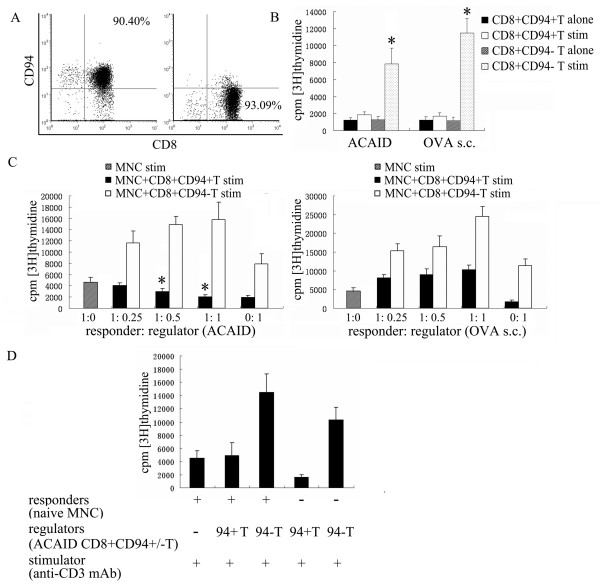
Suppressive activity exhibited by CD8+CD94+T cells from ACAID mice in vitro. A: the purity of isolated CD8+CD94+T (left) and CD8+CD94-T (right) cells by magnetic affinity cell sorting; B: the response of CD8+CD94+T and CD8+CD94-T cells to anti-CD3 mAb stimulation (stim). *p < 0.05 compared with unstimulated group. C: suppressive effect of CD8+CD94+T and CD8+CD94-T cells on the proliferation of splenic MNC. Splenic MNC (5 × 104 cells/well, as responder cells) from immunized mice were cocultured with purified CD8+CD94+T or CD8+CD94-T cells (as regulatory cells) from ACAID mice and immunized mice at different responder/suppressor ratios (1:0, 1:0.25, 1:0.5 and 1:1) in the presence of OVA(100 μg/ml) and anti-CD3 mAb(1 μg/ml) for 72 hours and pulsed with [3H]thymidine for the last 16 hours of culture. Data are represented as mean ± SEM of triplicate samples. *p < 0.05 compared with stimulated MNC group. D: suppressive effect of CD8+CD94+T and CD8+CD94-T cells from ACAID mice on the proliferation of splenic MNC from naive mice (at 1:1 ratio) upon anti-CD3 mAb(1 μg/ml) stimulation.